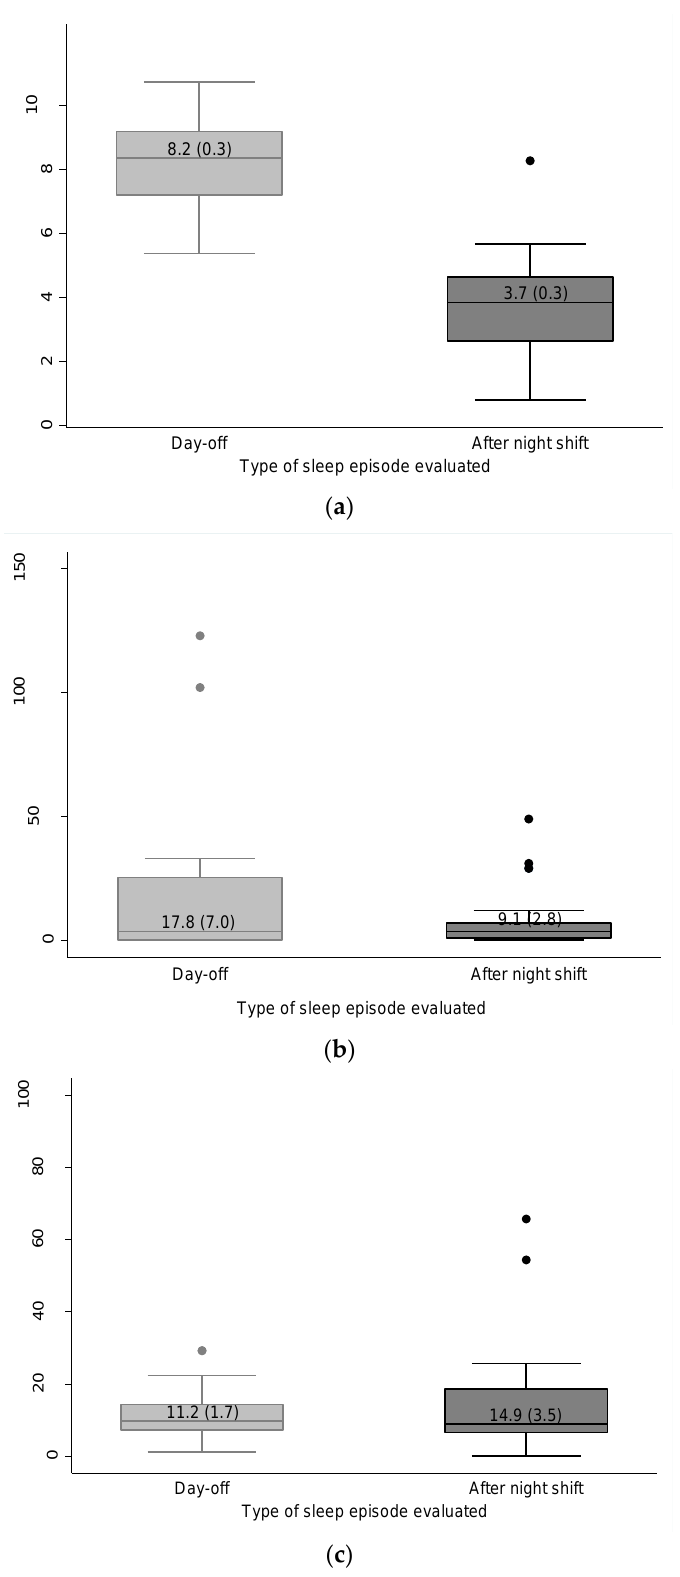
Figure 1. Sleep parameters obtained by actigraphy after night work (diurnal sleep, n = 22) and on day-off (nocturnal sleep, n = 22): ( a ) sleep duration (hours) (Paired t -test, p < 0.01) ( b ) sleep onset latency (minutes) (Wilcoxon p = 0.87) and ( c ) wake-up after sleep onset (%) (Wilcoxon p = 1.00). White lines represent means, gray boxes represent standard errors, and whiskers represent 95% confidence intervals.